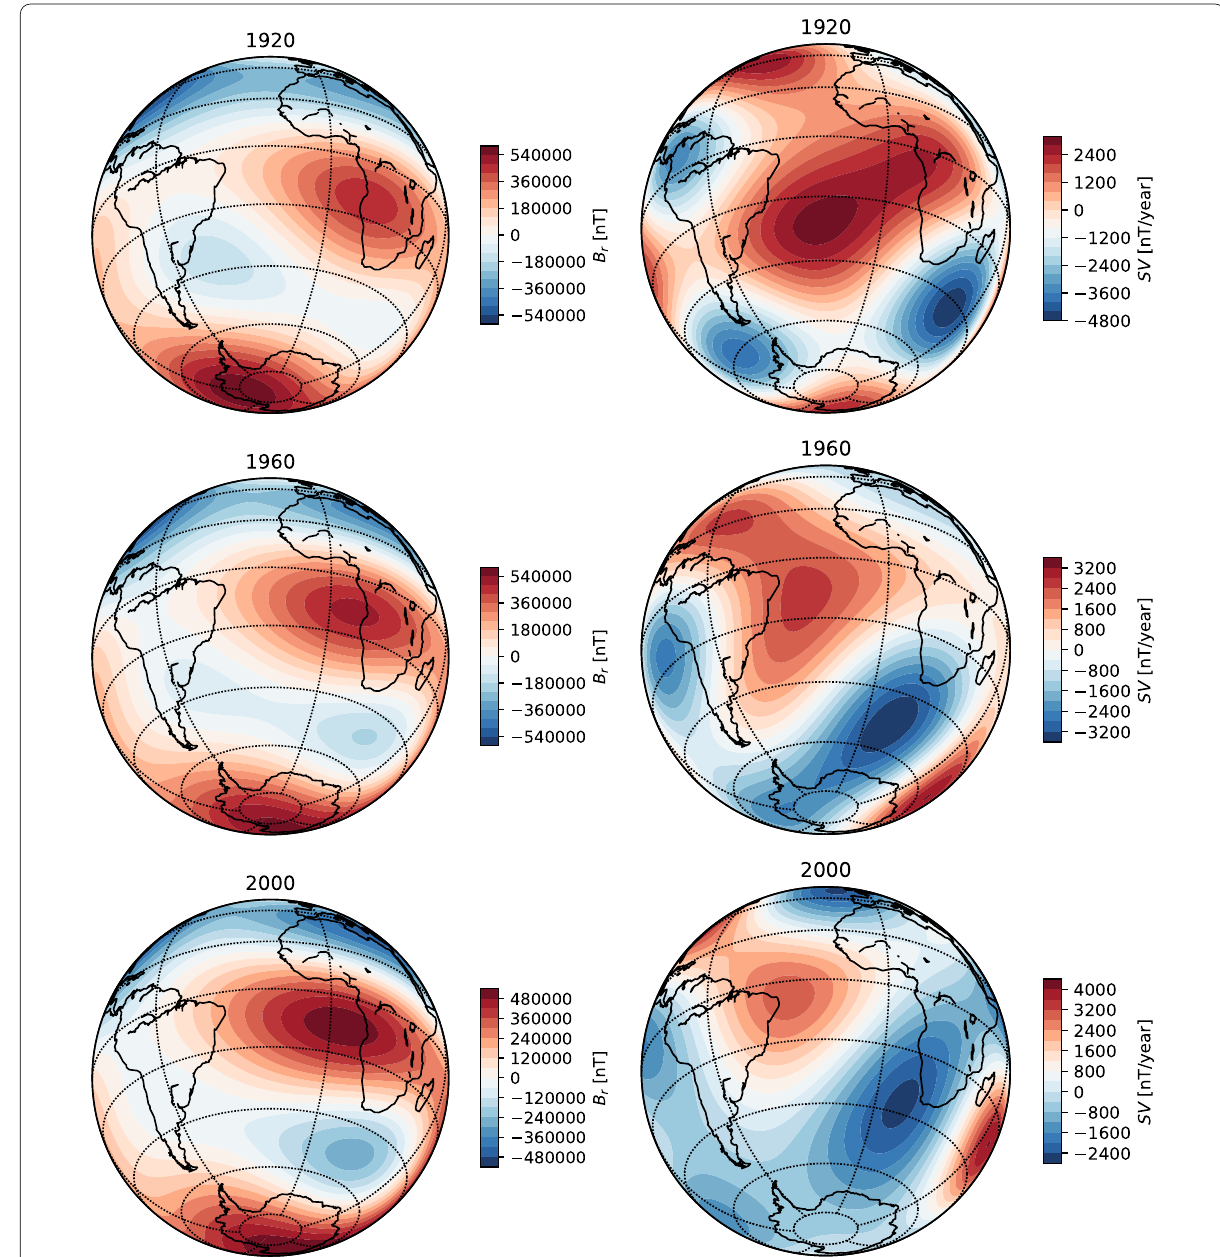
Fig. 5 Radial geomagnetic field (left) and its secular variation (right) at the core–mantle boundary for the mean model of COV‑OBS.x1 in 1920 (top), 1960 (middle) and 2000 (bottom). All models are expanded until spherical harmonic degree and order 5. All maps are centered at 20 ◦ W 30 ◦ S , i.e. on the South Atlantic. Note the different